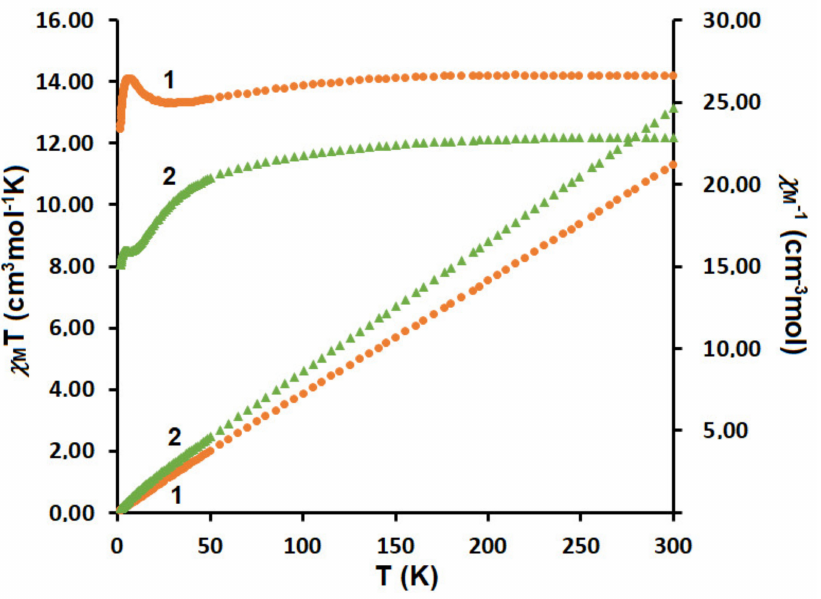
Figure 8. Temperature dependence of experimental χ M T and χ M − 1 versus T for 1 and 2